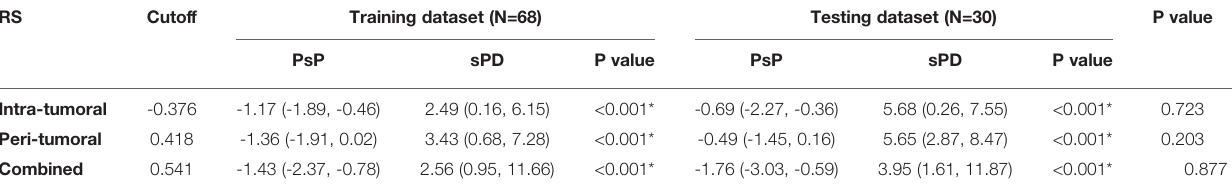
TABLE 3-2 | The distribution of the radiomics scores for PsP vs HPD in the training and testing datasets. RS Cutoff